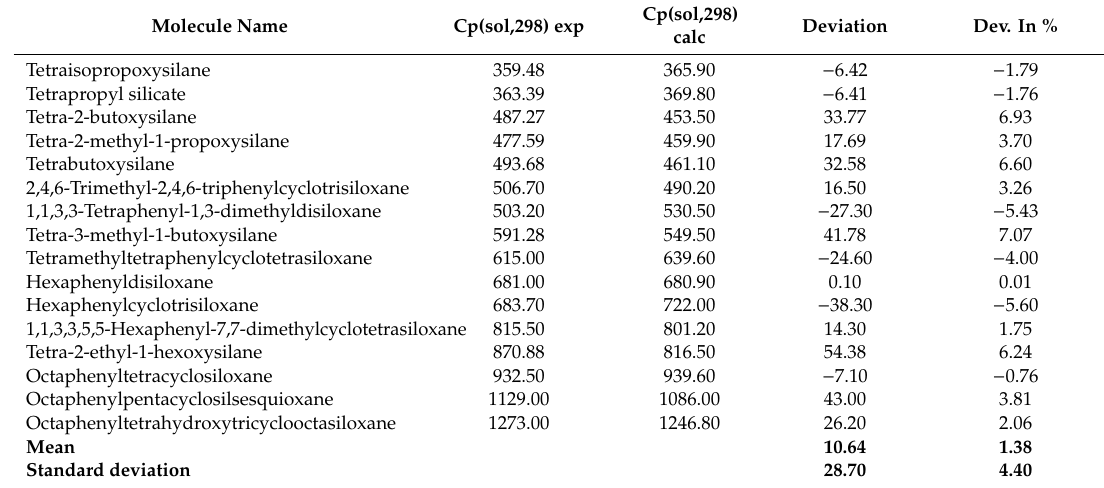
Table 12. Experimental and Equation (5)-calculated Cp(sol.298) of 16 siloxanes in J / mol /